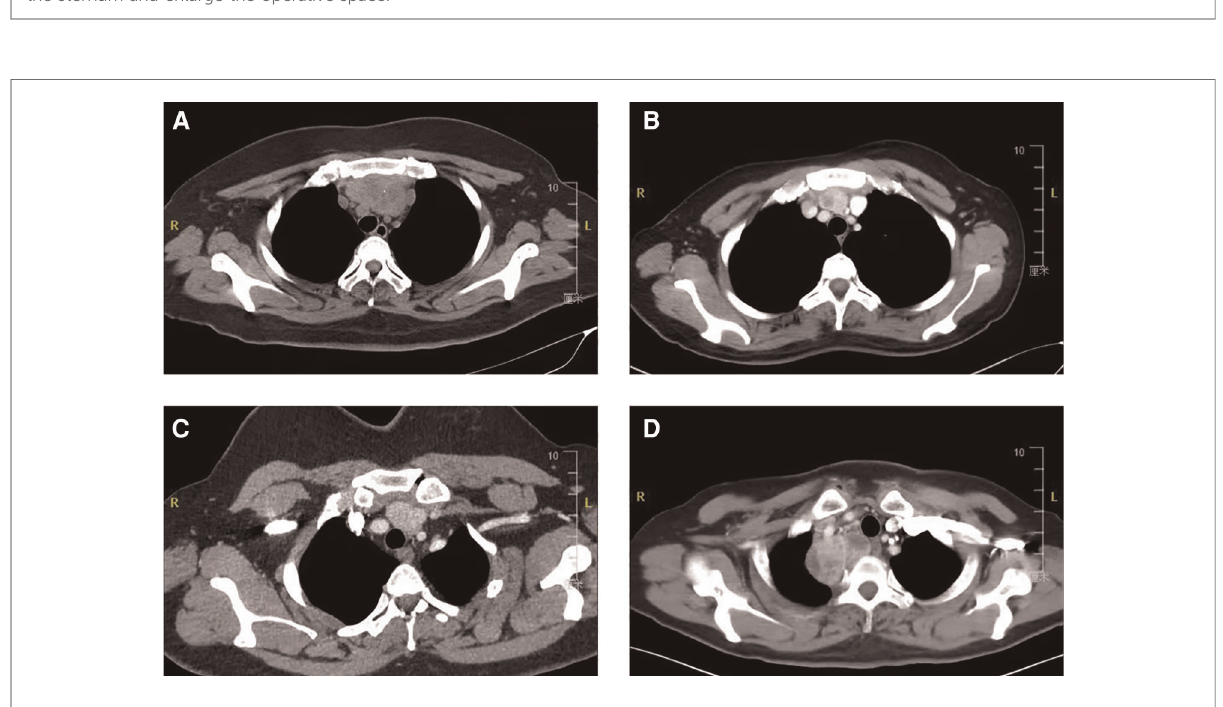
FIGURE 3 CT images of a retrosternal goiter. A series of patients with retrosternal goiters went through chest CT scan. Masses located in the mediastinum, next to the airway and great vessels, and compression on surrounding blood vessels and trachea could be observed in some